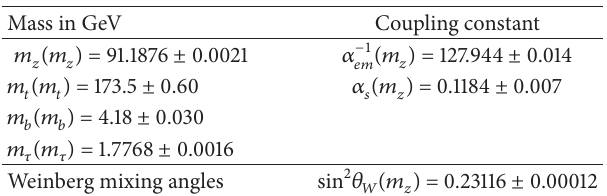
Table 1: Experimental input values for fermion masses, gauge couplings, and Weinberg angle at electroweak scale 𝑚 𝑧 [26]. Mass in GeV Coupling constant 𝑚 (𝑚 ) = 91.1876 ± 𝑧 𝑧